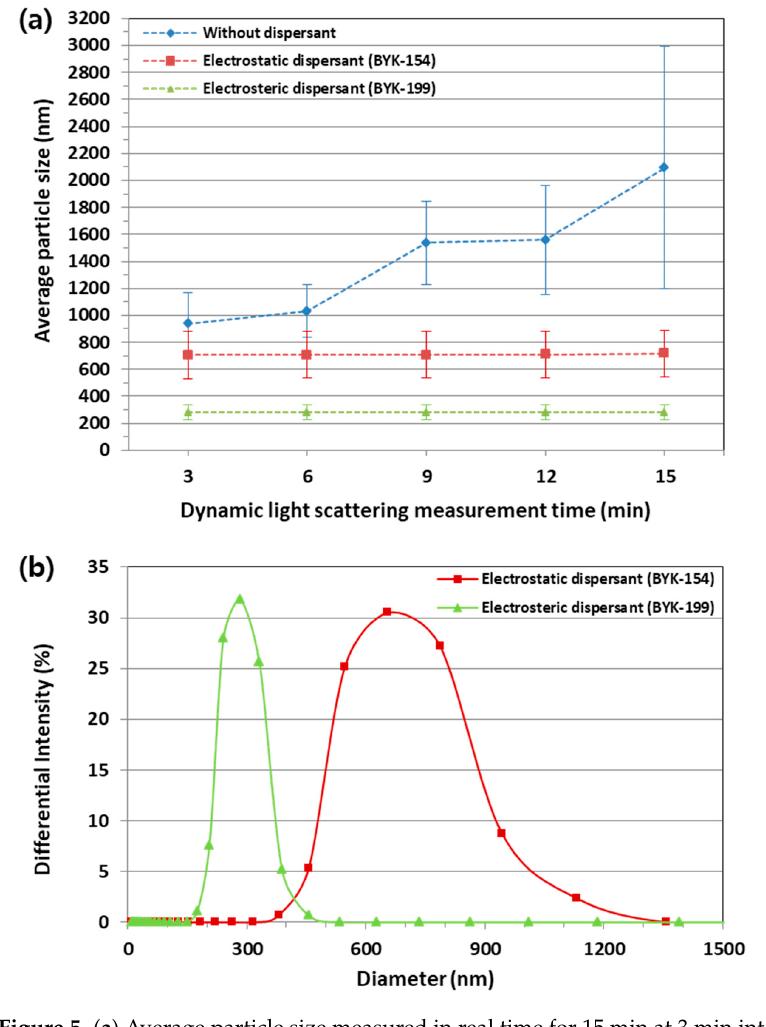
Figure 5. ( a ) Average particle size measured in real time for 15 min at 3 min intervals and ( b ) particle size distributions of Y 5 O 4 F 7 suspensions measured by DLS.